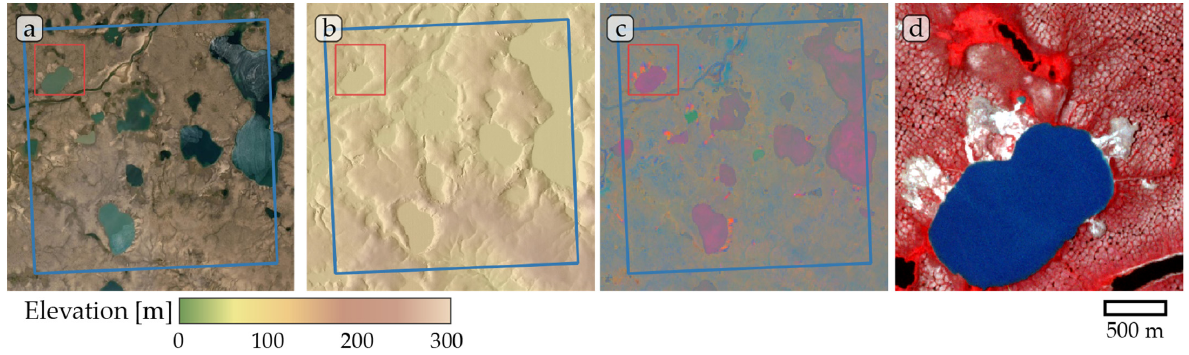
Figure A2. Study site Banks Island 02. ( a ) ESRI satellite layer, ( b ) ArcticDEM superimposed with hillshade, ( c ) Tasseled Cap trend visualization, ( d ) PlanetScope satellite image (NIR-R-G) acquired on 27 July 2019. Blue box, 10 × 10 km study site. Red box detailed view of ( d ).